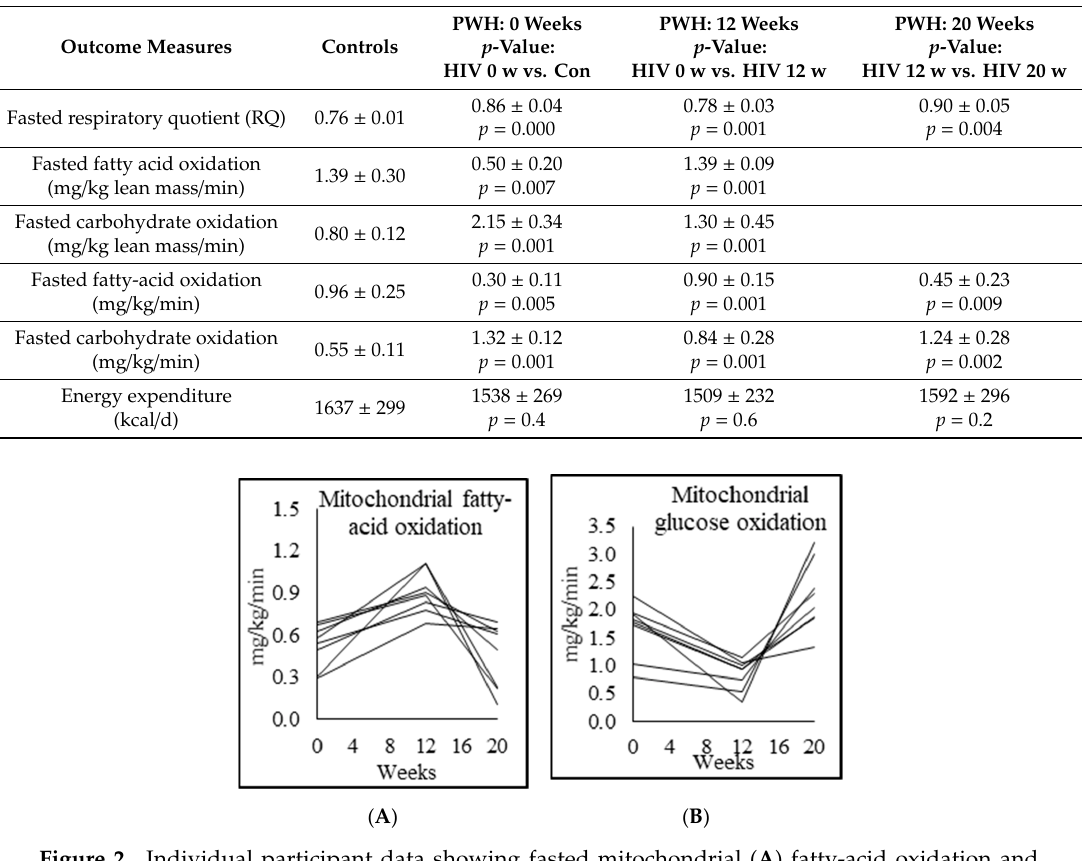
Figure 2. Individual participant data showing fasted mitochondrial ( A ) fatty-acid oxidation and ( B ) glucose oxidation.